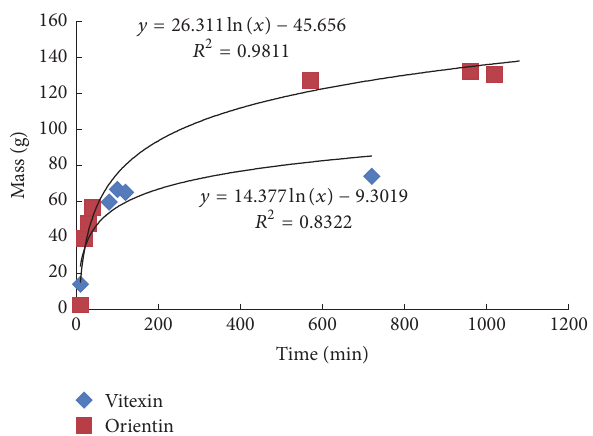
Figure7:Pelegmodelkineticequilibriumextractionoforientinand vitexin dried leaves extract ( 𝑛 = 3 ).